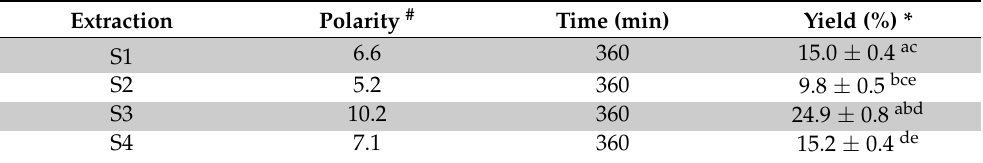
Table 1. Soxhlet extraction yields of E. arvense L. using different solvents. The yield values (%) are expressed as mean ± SD from 3 independent measurements in each case. Values that share the same letter differ from each other (Mann–Whitney u-test, p <